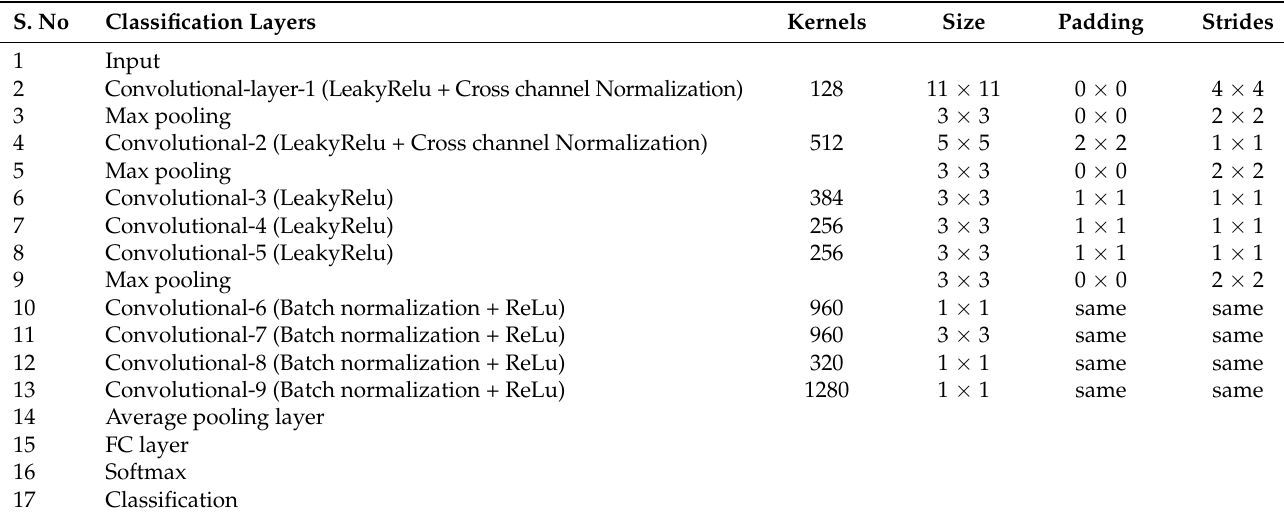
Table 1. CovidDetNet architecture parameters.